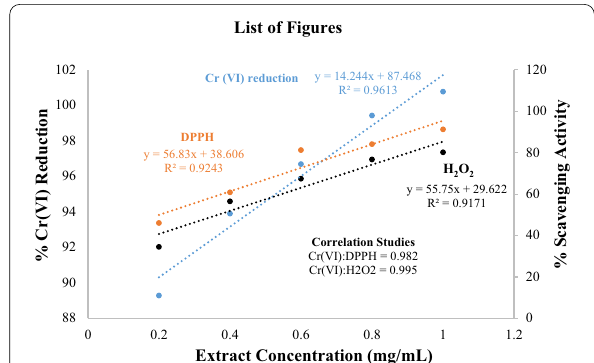
Extract Concentration (mg/mL) Fig. 1 Relationship between Cr (VI) reduction capacity and antioxidant activity of Tamarindus indica methanol leaves extract. DPPH 2, 2-diphenyl-1-picrylhydrazyl, H 2 O 2 Hydrogen peroxide = = assay